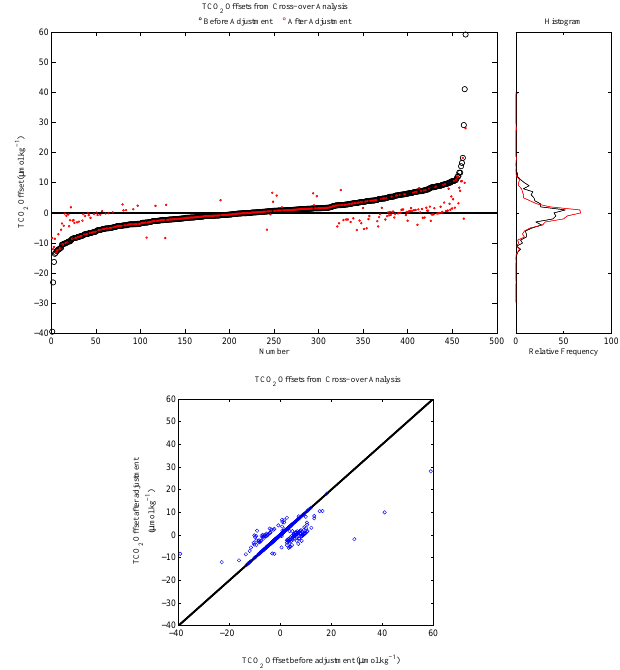
Figure 5. Top graph: Plot of the o ff sets in TCO 2 for all crossovers before adjustments (black symbols) in ascending order (Number) from left to right. The red symbols are the o ff sets after adjust- ments were made. Bottom graph: Scatter plot of the o ff sets after adjustments versus the same o ff sets before adjustments. O ff sets for cruises which have not been adjusted fall on the 1:1 line (black